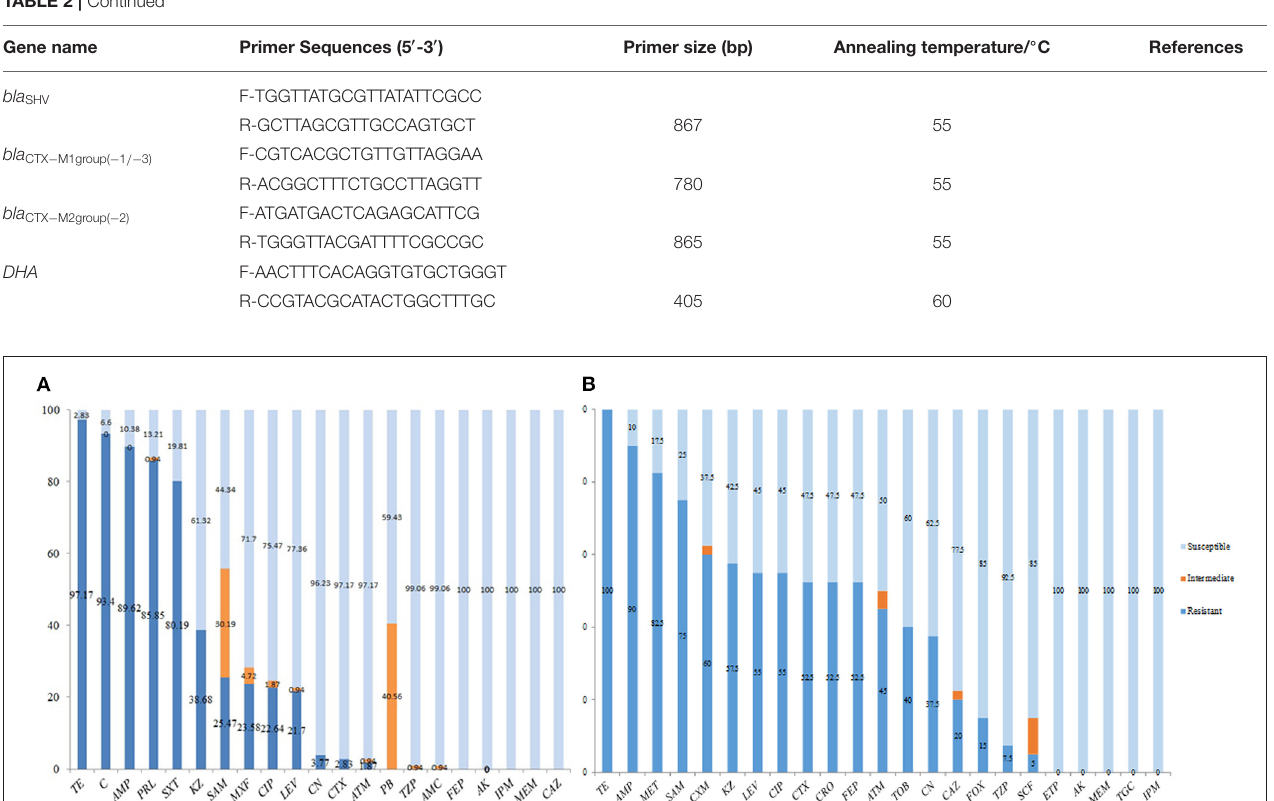
FIGURE 1 | Antibiotic susceptibility testing of swine origin Escherichia coli . (A) 21 antibiotics were tested and 13 kinds displayed high resistance to E. coli strains in swines as tetracycline (TE) was the highest one (97.17%), followed by chloramphenicol (C, 93.4%), ampicillin (AMP, 89.62%), piperacillin (PRL, 85.85%), and trimethoprim/sulfamethoxazole (SXT, 80.19%). The rates of the resistance to E. coli strains in other swines were lower as cefazolin (KZ, 38.68%), ampicillin/sulbactam (SAM, 25.47%), moxifloxacin (MXF, 23.58%), ciprofloxacin (CIP, 22.64%), levofloxacin (LEV, 21.7%), gentamicin (CN, 3.77%), cefotaxime (CTX, 2.83%), and aztreonam (ATM, 1.87%). (B) In addition to TE (100%), the other 22 antibiotics with high resistance to human-derived E. coli strains were AMP (90%), followed by methicillin (MET, 82.5%), SAM (75%), cefuroxime (CXM, 60%), KZ (57.5%), LEV (55%), CIP (55%), CTX (52.5%), ceftriaxone (CRO, 52.5%), cefepime (FEP, 52.5%), ATM (45%), tobramycin (TOB, 40%), CN (37.5%), ceftazidime (CAZ, 20%), cefoxitin (FOX, 15%), piperacillin tazobactam (TZP, 7.5%), and cefoperazone/sulbactam (SCF, 5%). In addition, the other five species [i.e., ertapenem (ETP), amikacin (AK), meropenem (MEM), tigecycline (TGC), and imipenem (IPM)] were sensitive.